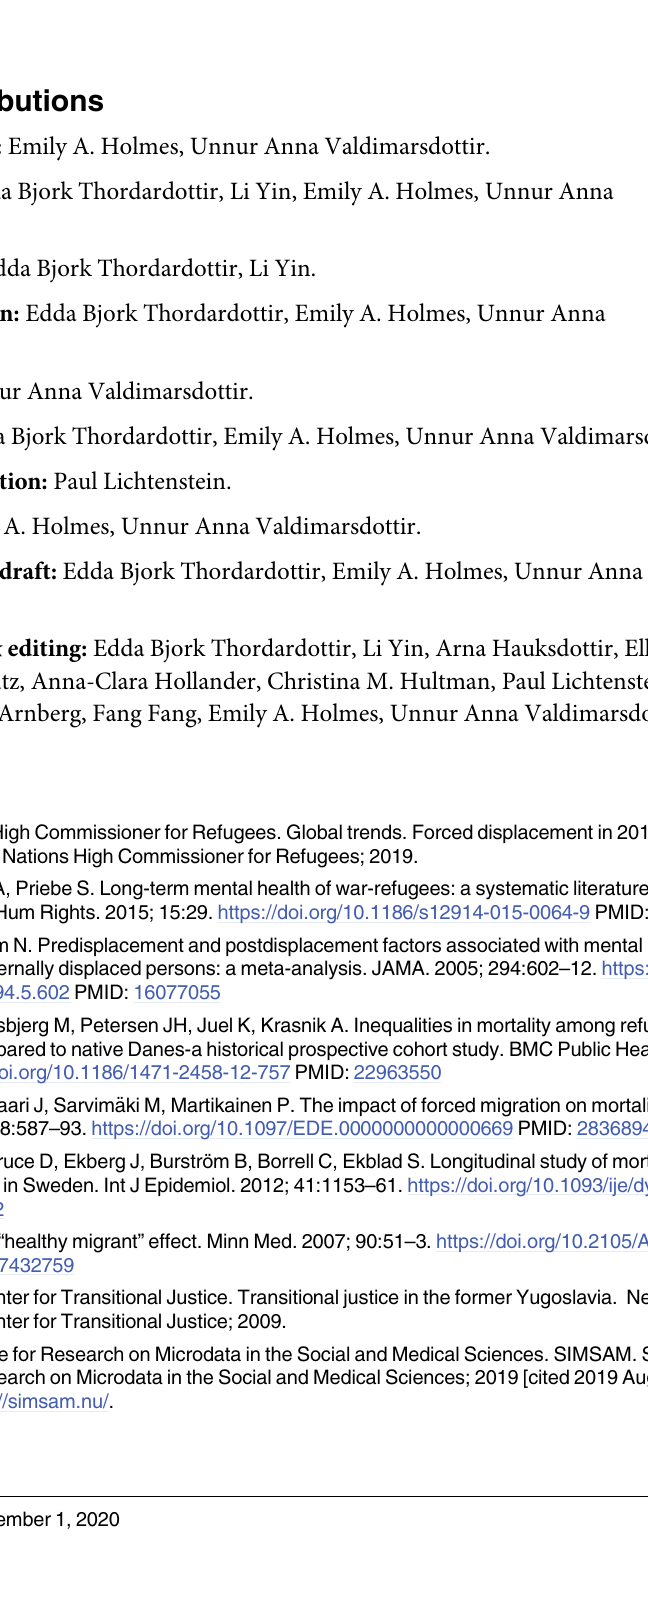
S6 Table. Mortality and morbidity rates among migrants of the Balkan wars (exposed) compared to other European migrants (unexposed), with regard to whether individuals with missing education level are